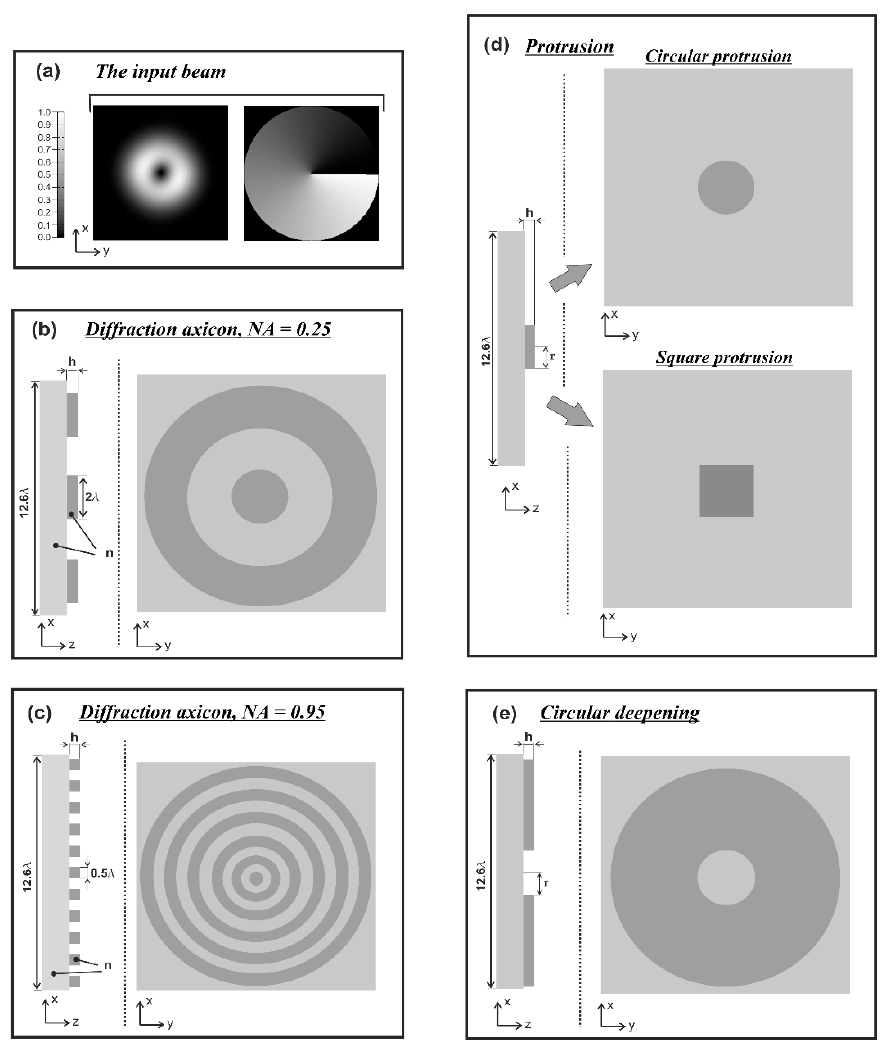
Figure 1. Input laser radiation and considered optical elements: input beam ( a ), diffractive axicon with NA = 0.25 ( b ) and NA = 0.95 ( c ), circular and square protrusion ( d ), circular deepening ( e ). Modeling parameters: radiation wavelength λ = 1.55 µ m, size of the